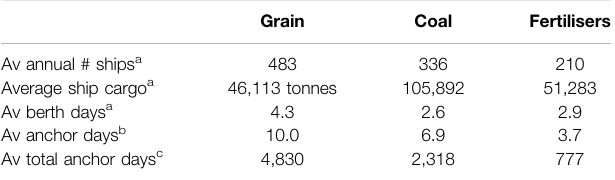
TABLE 1 | Ships, average cargo, anchorage and berth time by commodity, 2015 –